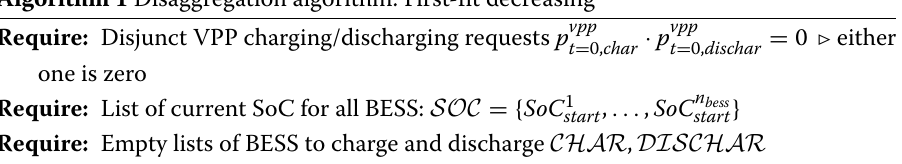
Algorithm 1 Disaggregation algorithm: First-fit